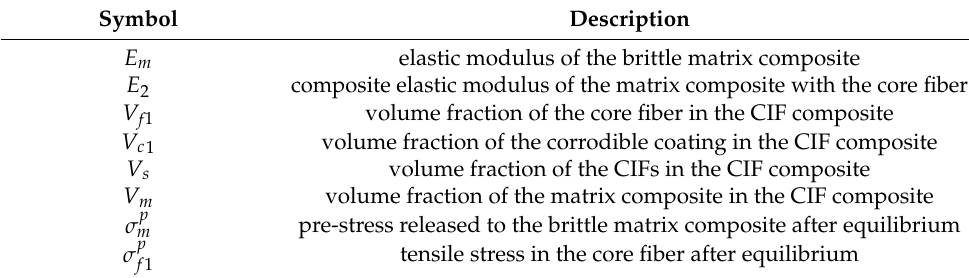
Table A2. Symbols in formula deduction for CIF